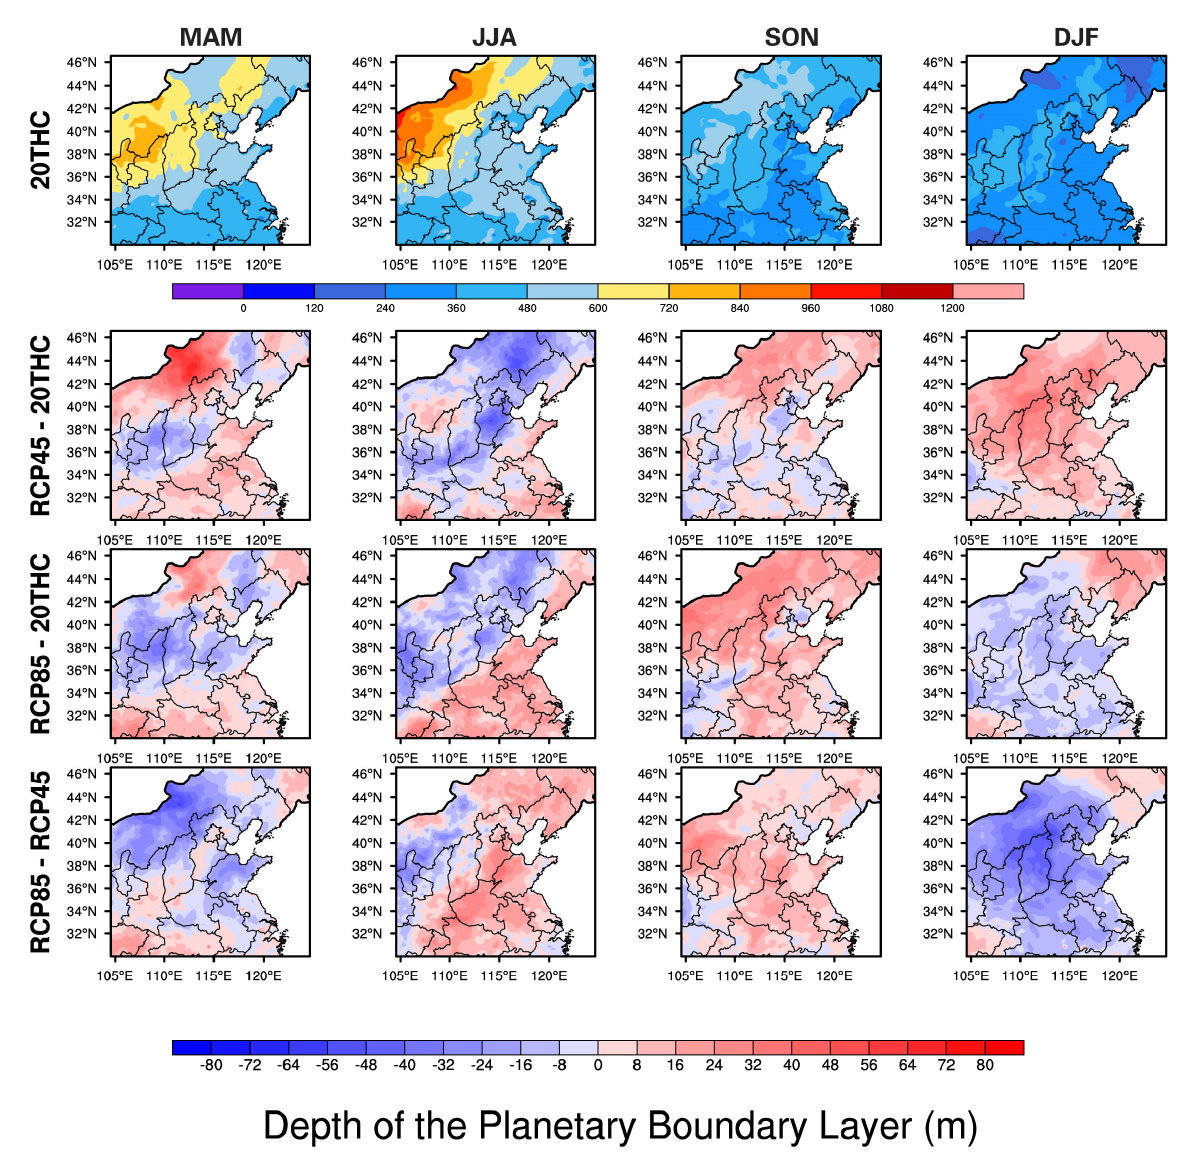
Figure 9. The same as Figure 8 but for the level of boundary layer. Precipitation in NC was mainly concentrated in summer due to the influence of the East Asian monsoon, followed by autumn, spring, and winter. Compared to the historic period, precipitation was projected to increase over all of NC in spring under the two scenarios. It is noted that the greatest increases of precipitation were in summer, with a value of 1.5 mm/day in BTH. On a regional scale, the changes in precipitation responded relatively well to the pollution (Figures 6 and 7) in spring and summer. In autumn, changes of precipitation both showed entire decreasing patterns. Under